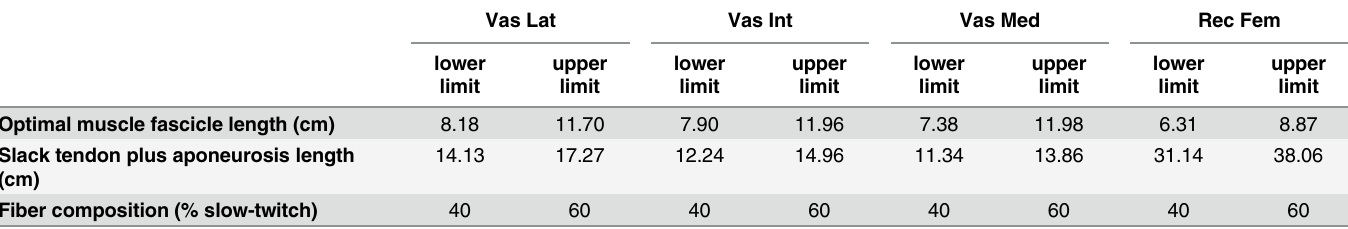
Table 2. Ranges over which musculoskeletal parameters were adjusted for sensitivity analysis. Range limits for each parameter represent one stan- dard deviation above and below the human subject mean. See S3 Appendix for